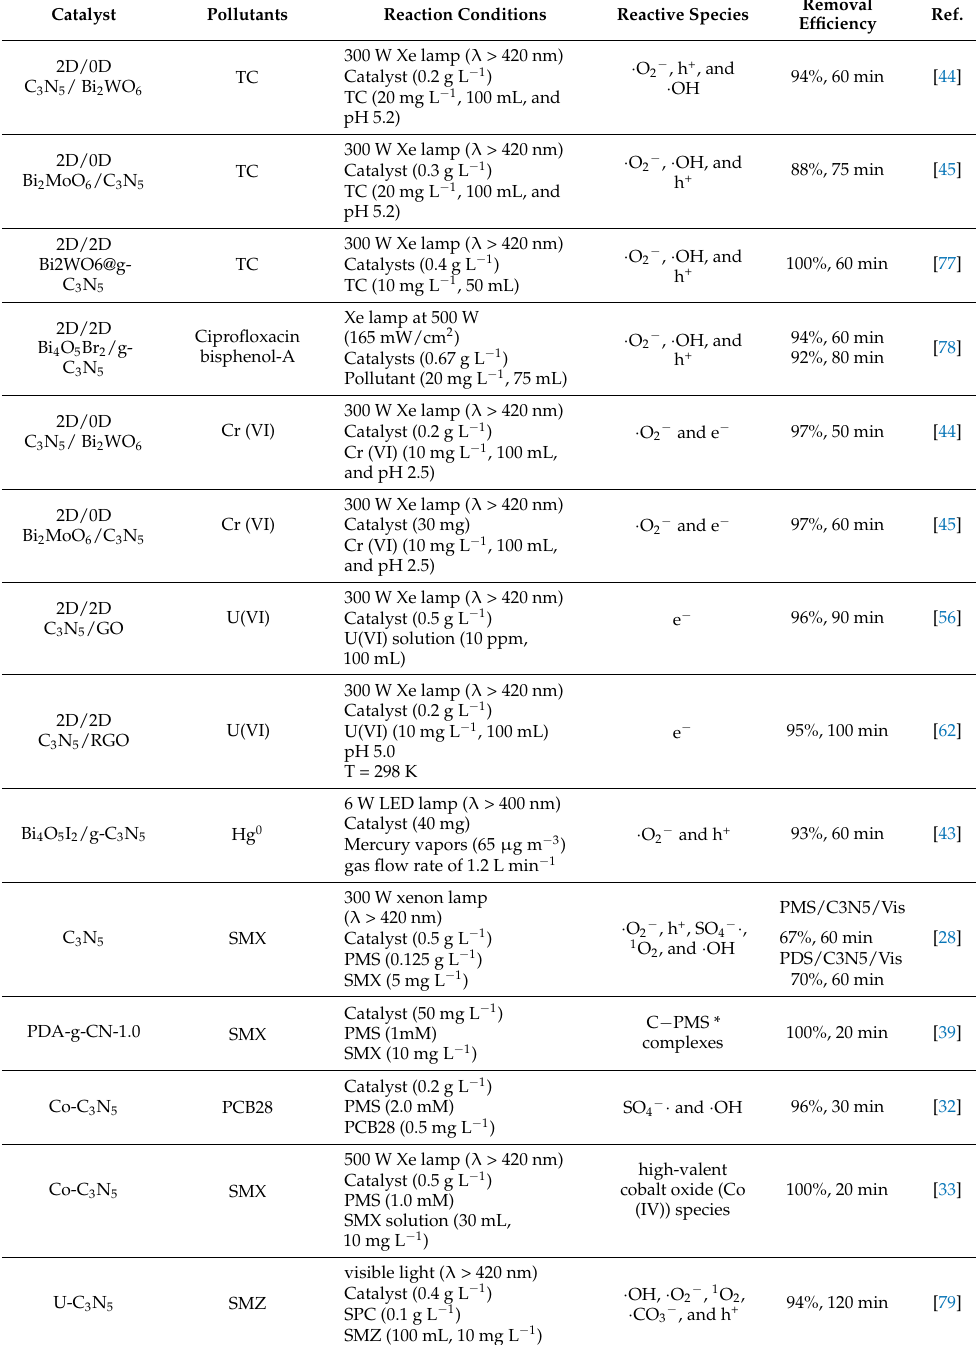
Table 3. Cont . Catalyst Pollutants Reaction Conditions Reactive Species Removal Efficiency